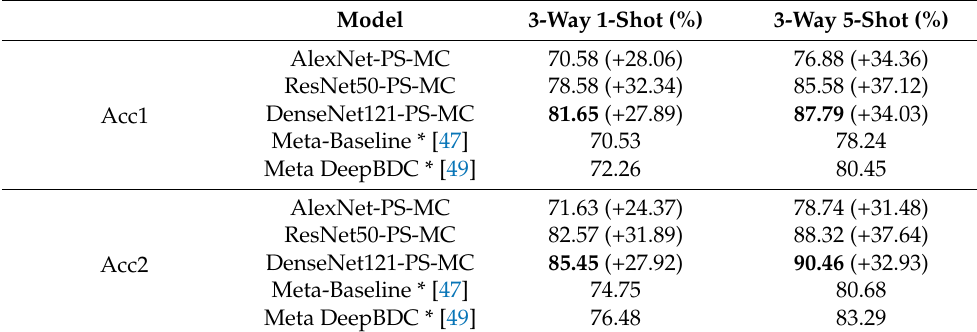
Table 6. Performance comparison of the proposed method and others on the test set. The symbol * indicates that we have re-implemented Meta-Baseline [47] and Meta DeepBDC [49] with DenseNet 121 [28] as the backbone and adapted to accept four-channels inputs consisting of remote sensing images and DEM data. The best metrics are highlighted in bold